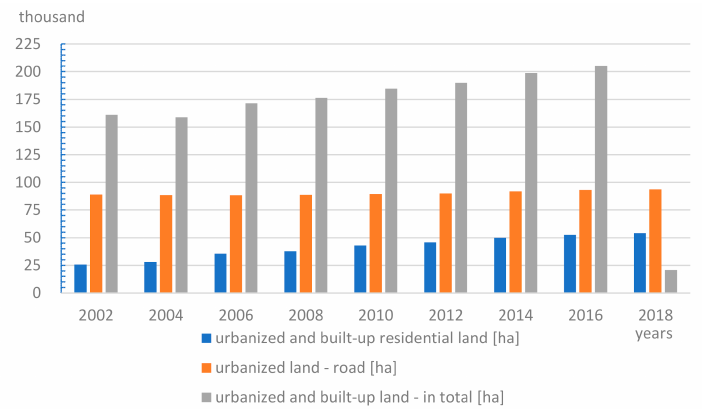
Figure 2. Changes concerning built-up land and roads in Mazowieckie Voivodeship in the years 2002–2018. Source: own study based on numerical data for specific years according to Table